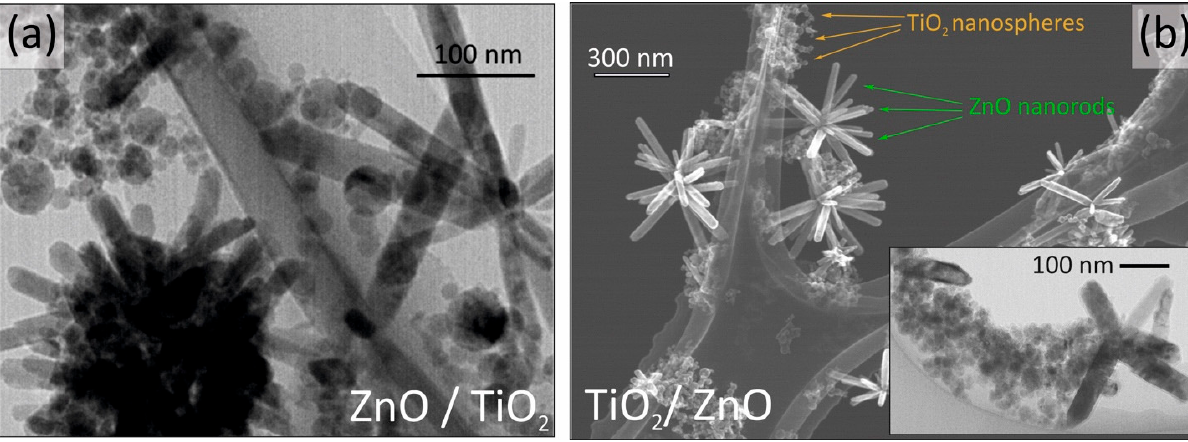
Figure 3. Electron microscopy images of samples ( a ) ZnO/TiO 2 and ( b ) TiO 2 /ZnO. ZnO as nanorods and TiO 2 as nanospheres are observed.